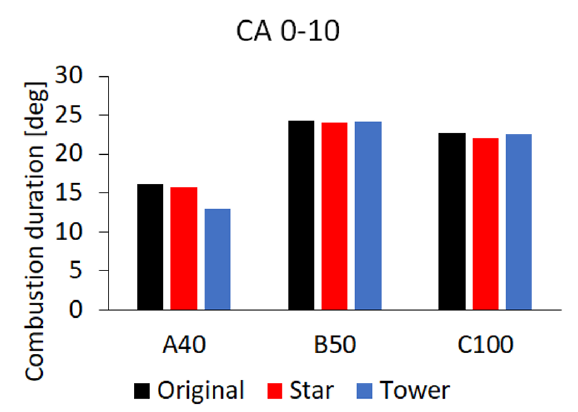
Figure 18. Comparison of the simulated combustion durations in terms of CA 0-10 for the analyzed operating conditions and the three different piston bowls.